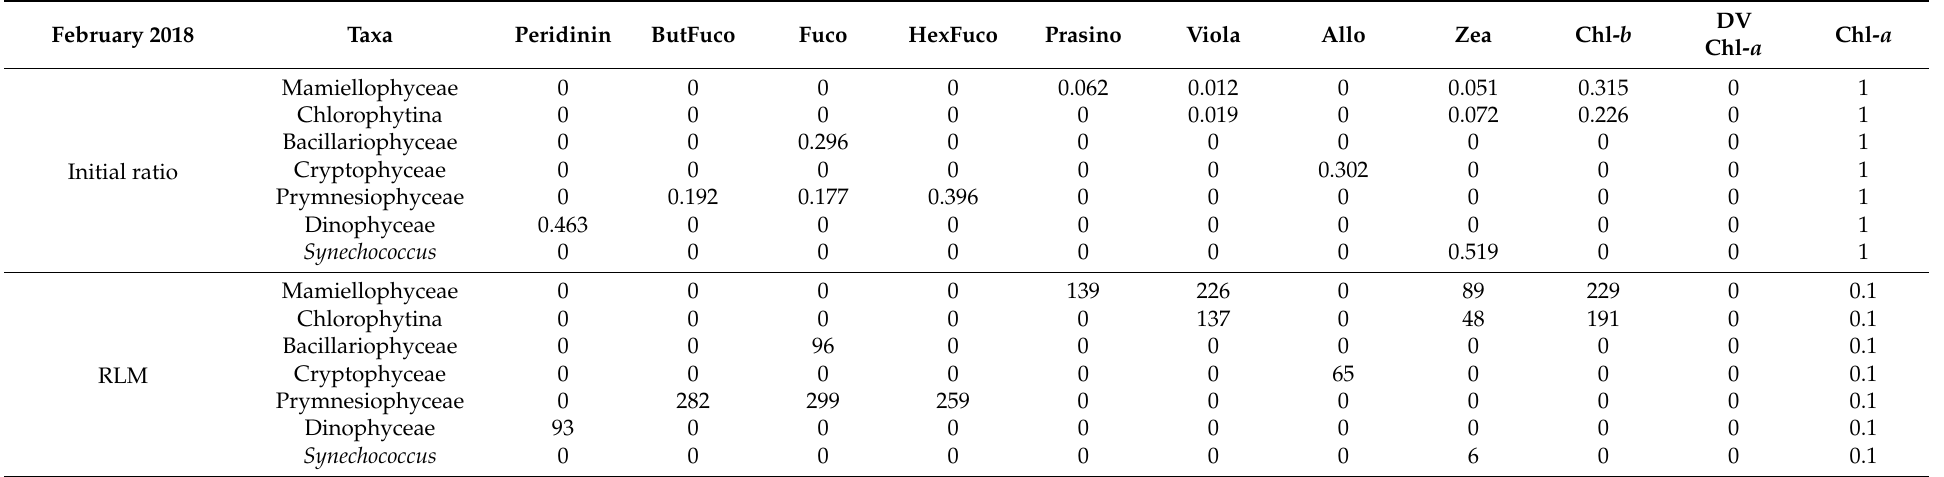
Table 6. Initial ratio and ratio limit for the February 2018